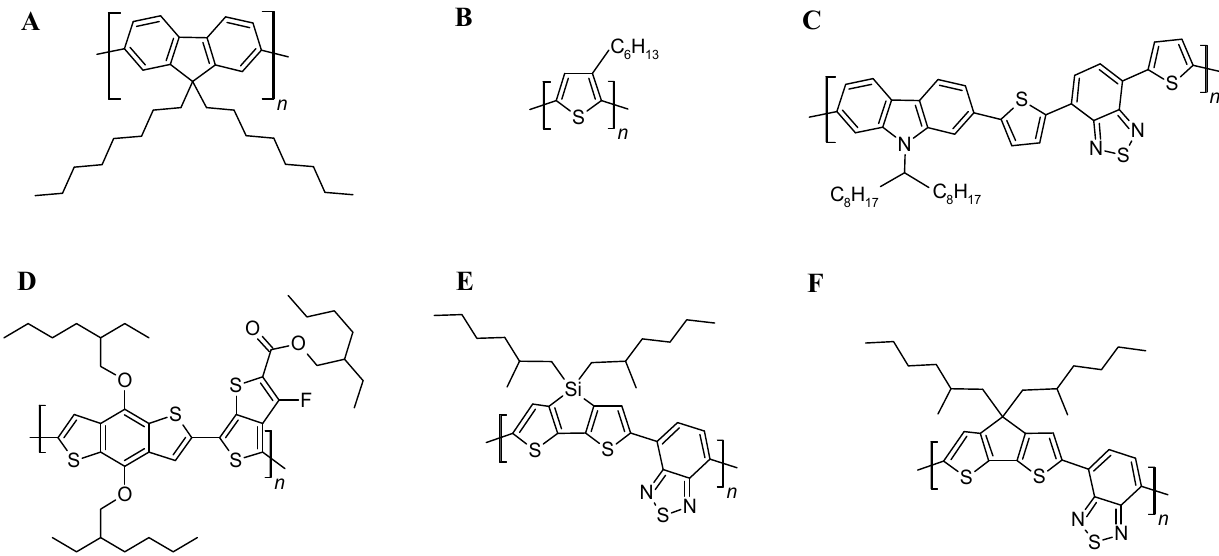
Figure 8. Chemical structure of polymers applied as active materials in organic solar cells: PFO- β ( A ), P3HT ( B ), PCDTBT ( C ), PTB7 ( D ), Si-PCPDTBT ( E ), and PCPDTBT ( F ).